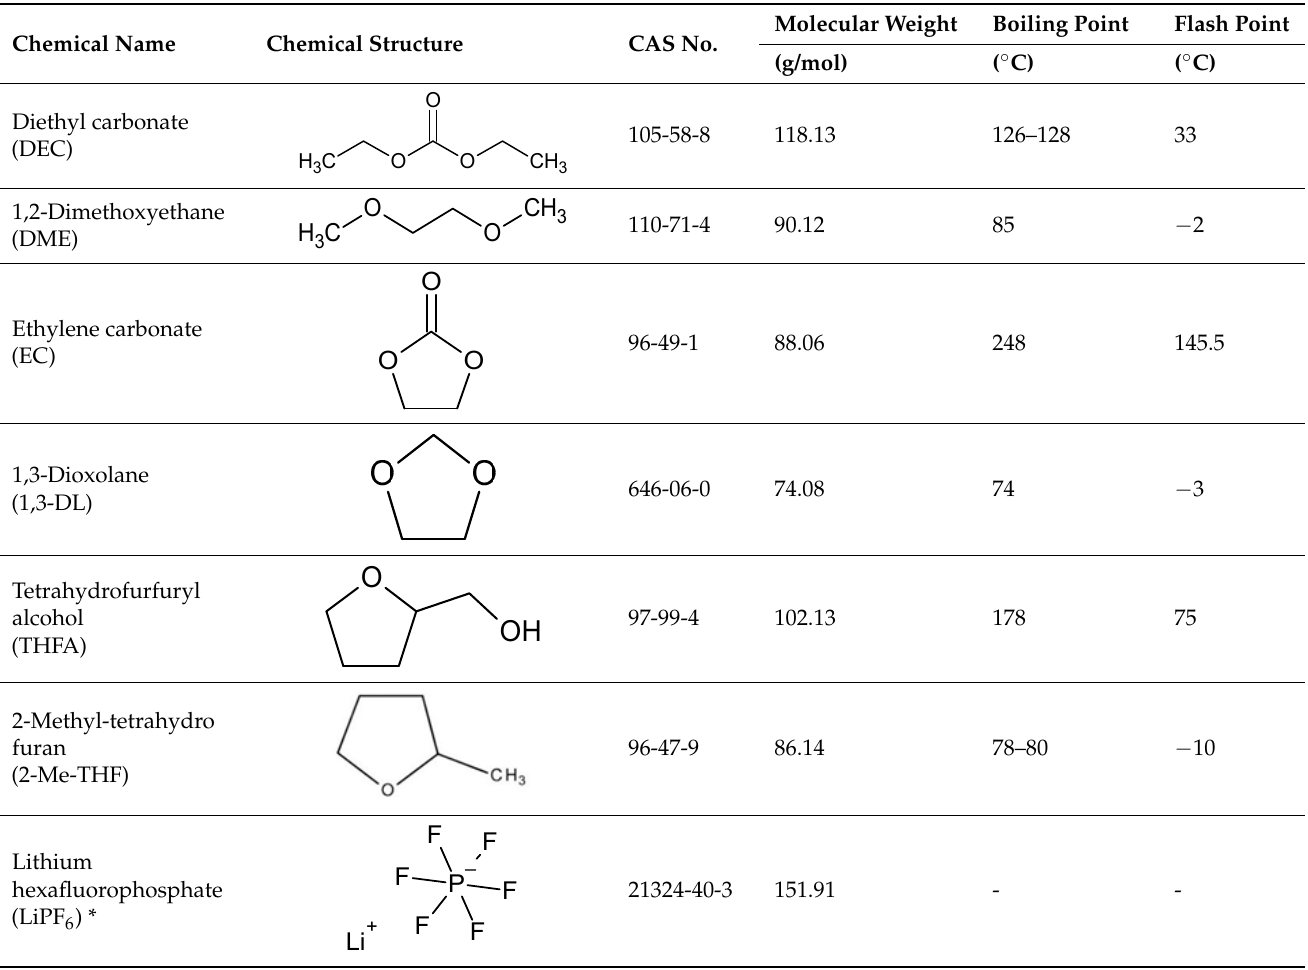
Table 1. Physicochemical characteristics of electrolyte materials.